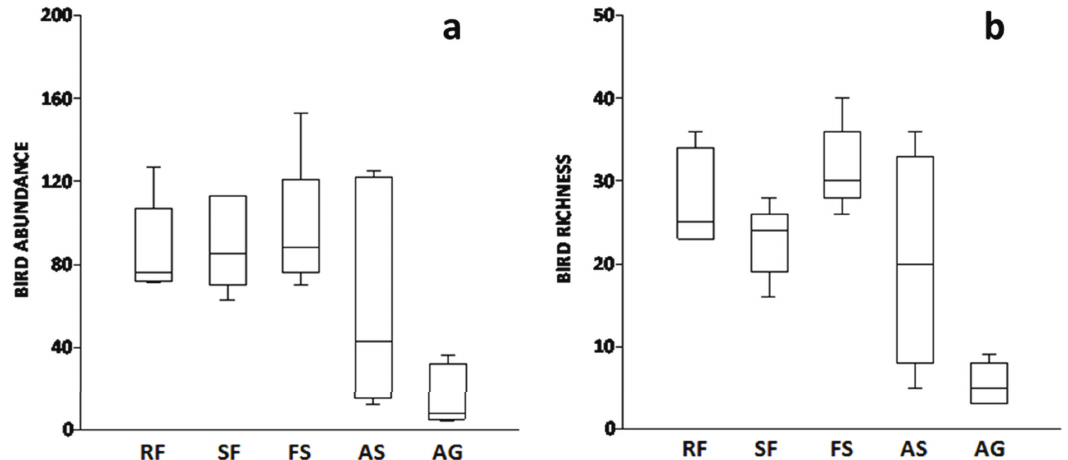
Figure 3 - Diff erences in bird abundance (a) and species richness (b) between vegetation types which occur in Maciço do Urucum, western Brazil. Legend: RF (Riparian Forests), SF (Submontane Forests), FS (Forested Savannas), AS (Arboreal Savannas), AG (Altitudinal